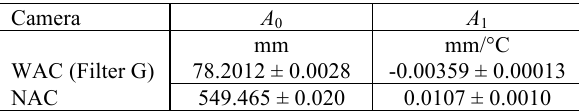
Tab. 1: Fit parameters for focal length function (Eq. 4). Parameters were obtained from a least-squares fit to measurements binned into 5° temperature ranges and weighted by the variance within the